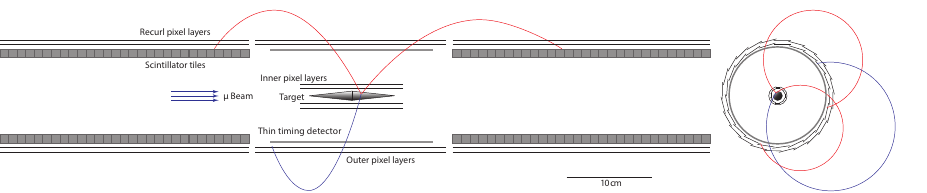
Figure 4. Schematic view of the Mu3e detector in the longitudinal and transverse planes, showing the recurling tracks of two positrons (in red) and one electron (in blue) issued from a muon decay on target